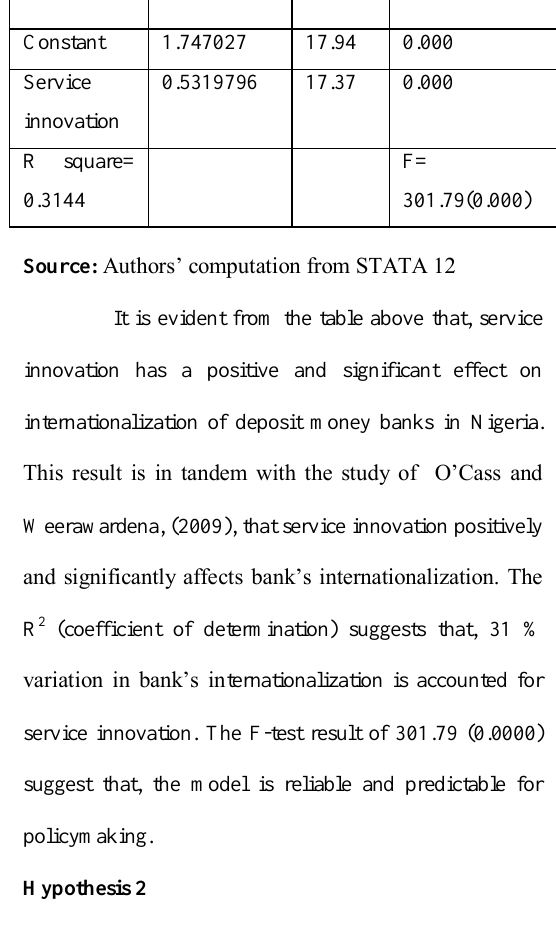
Table 2: Regression Results for Hypothesis 2